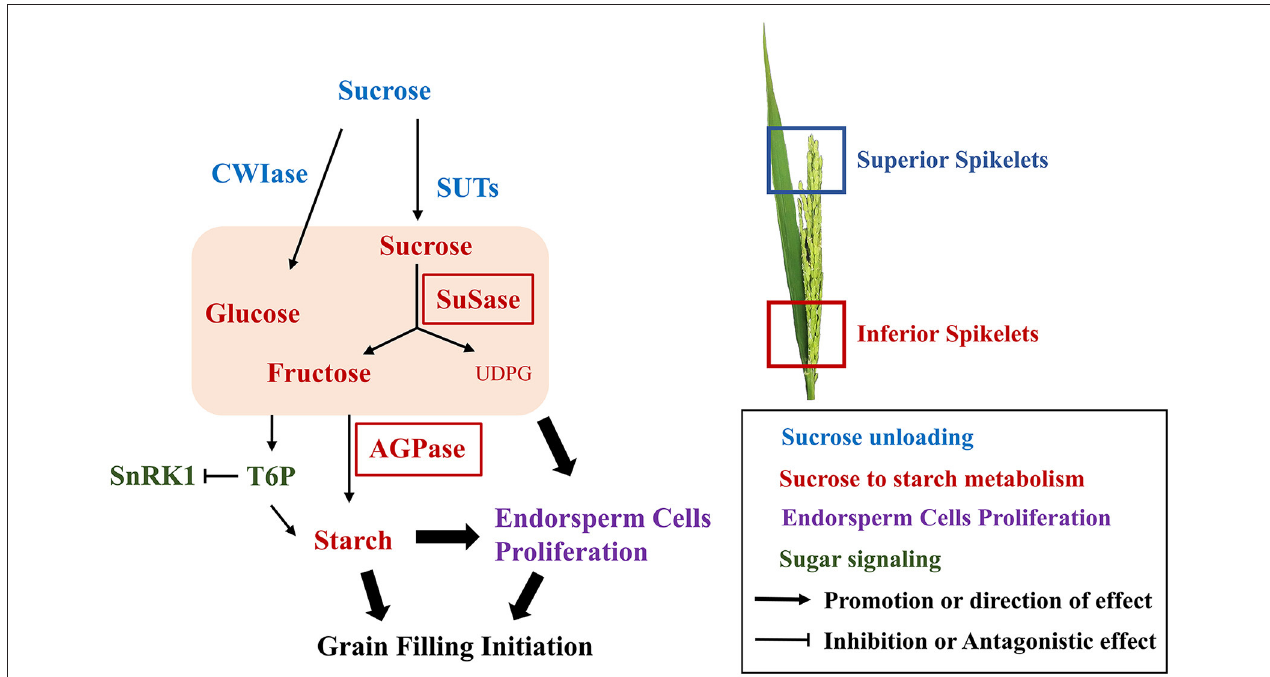
FIGURE 9 | Biochemical pathway to the grain-filling initiation. Solid arrows direction effects; broken line indicates the indirection of effect; different colors indicate various